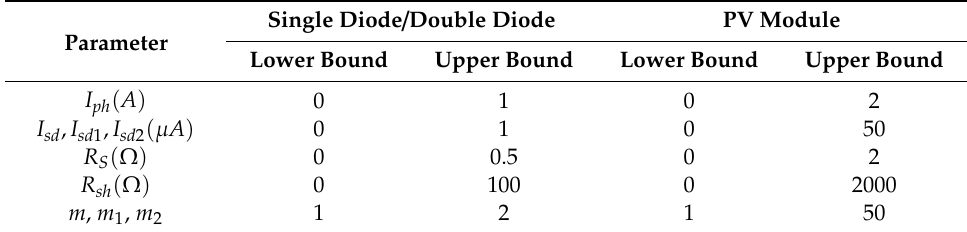
Table 1. Parameters boundaries of the three di ff erent photovoltaic (PV) models. Single Diode / Double Diode PV Module Parameter Lower Bound Upper Bound Lower Bound Upper